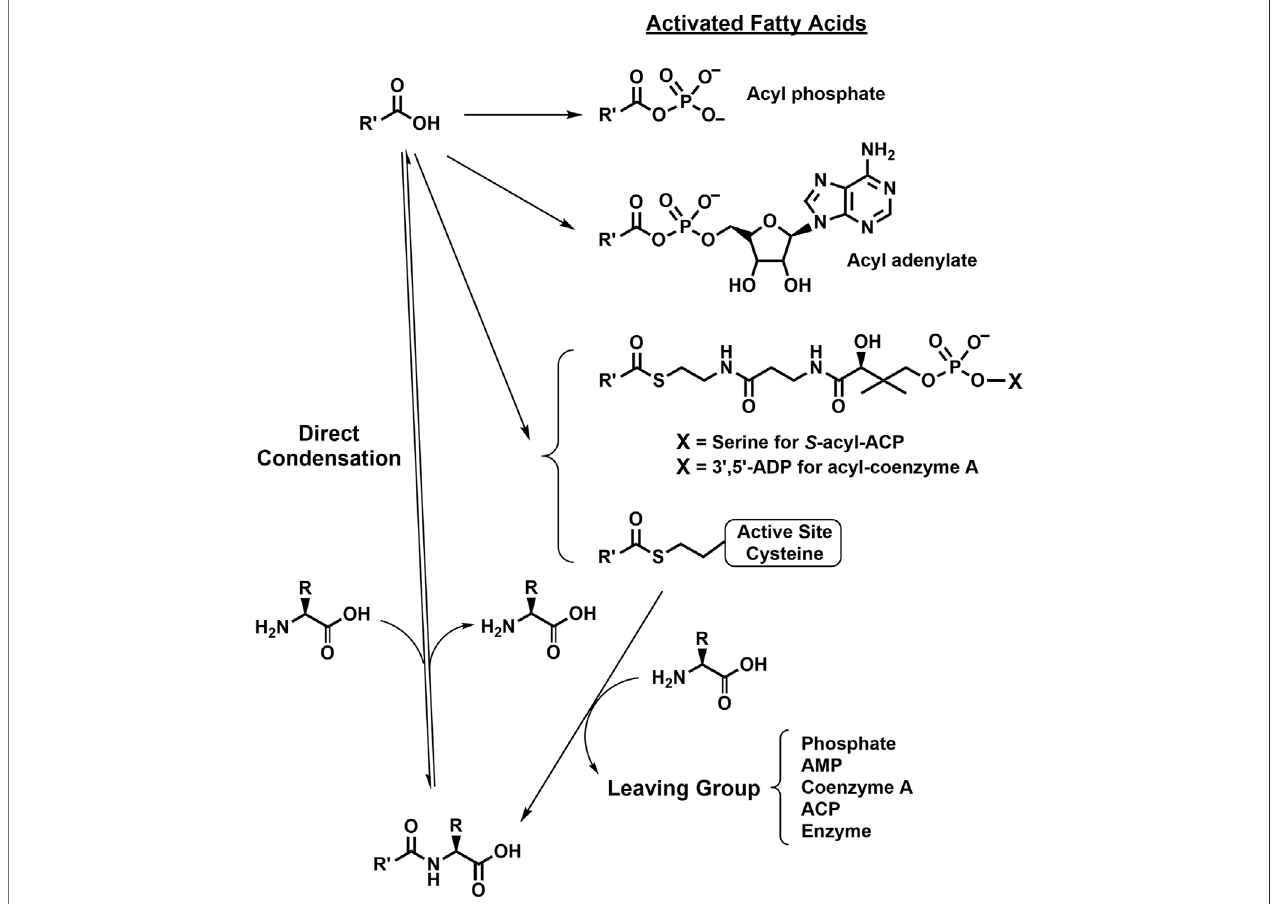
FIGURE 2 | Putative Biosynthetic Routes for the NA-ArAAs. Details for the biosynthesis of the activated fatty acids were omitted because some of the reactions have not been conclusively identi fi ed. However, all the activation reactions would likely be ATP-dependent, either directly or indirectly. The R-group represents the side- groups for the aromatic amino acids shown in Figure 1 and R ′ -CO- represents the acyl groups from Table 1